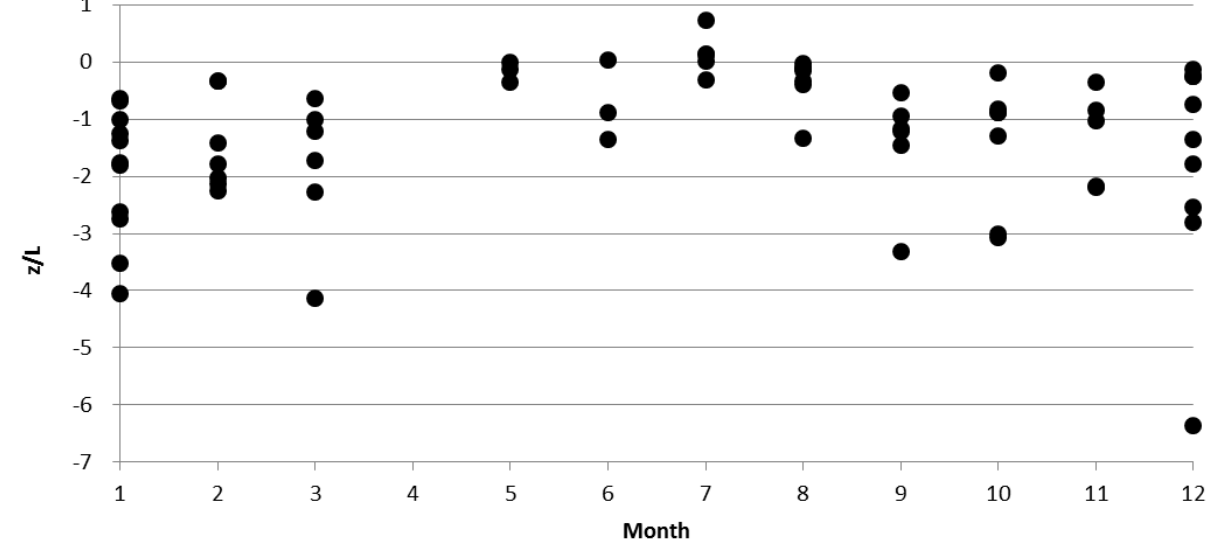
Figure 8. Monthly variation of z/L at Shirahama. But only 2 m/s or higher of the CMOD5.N-retrieved wind speed.